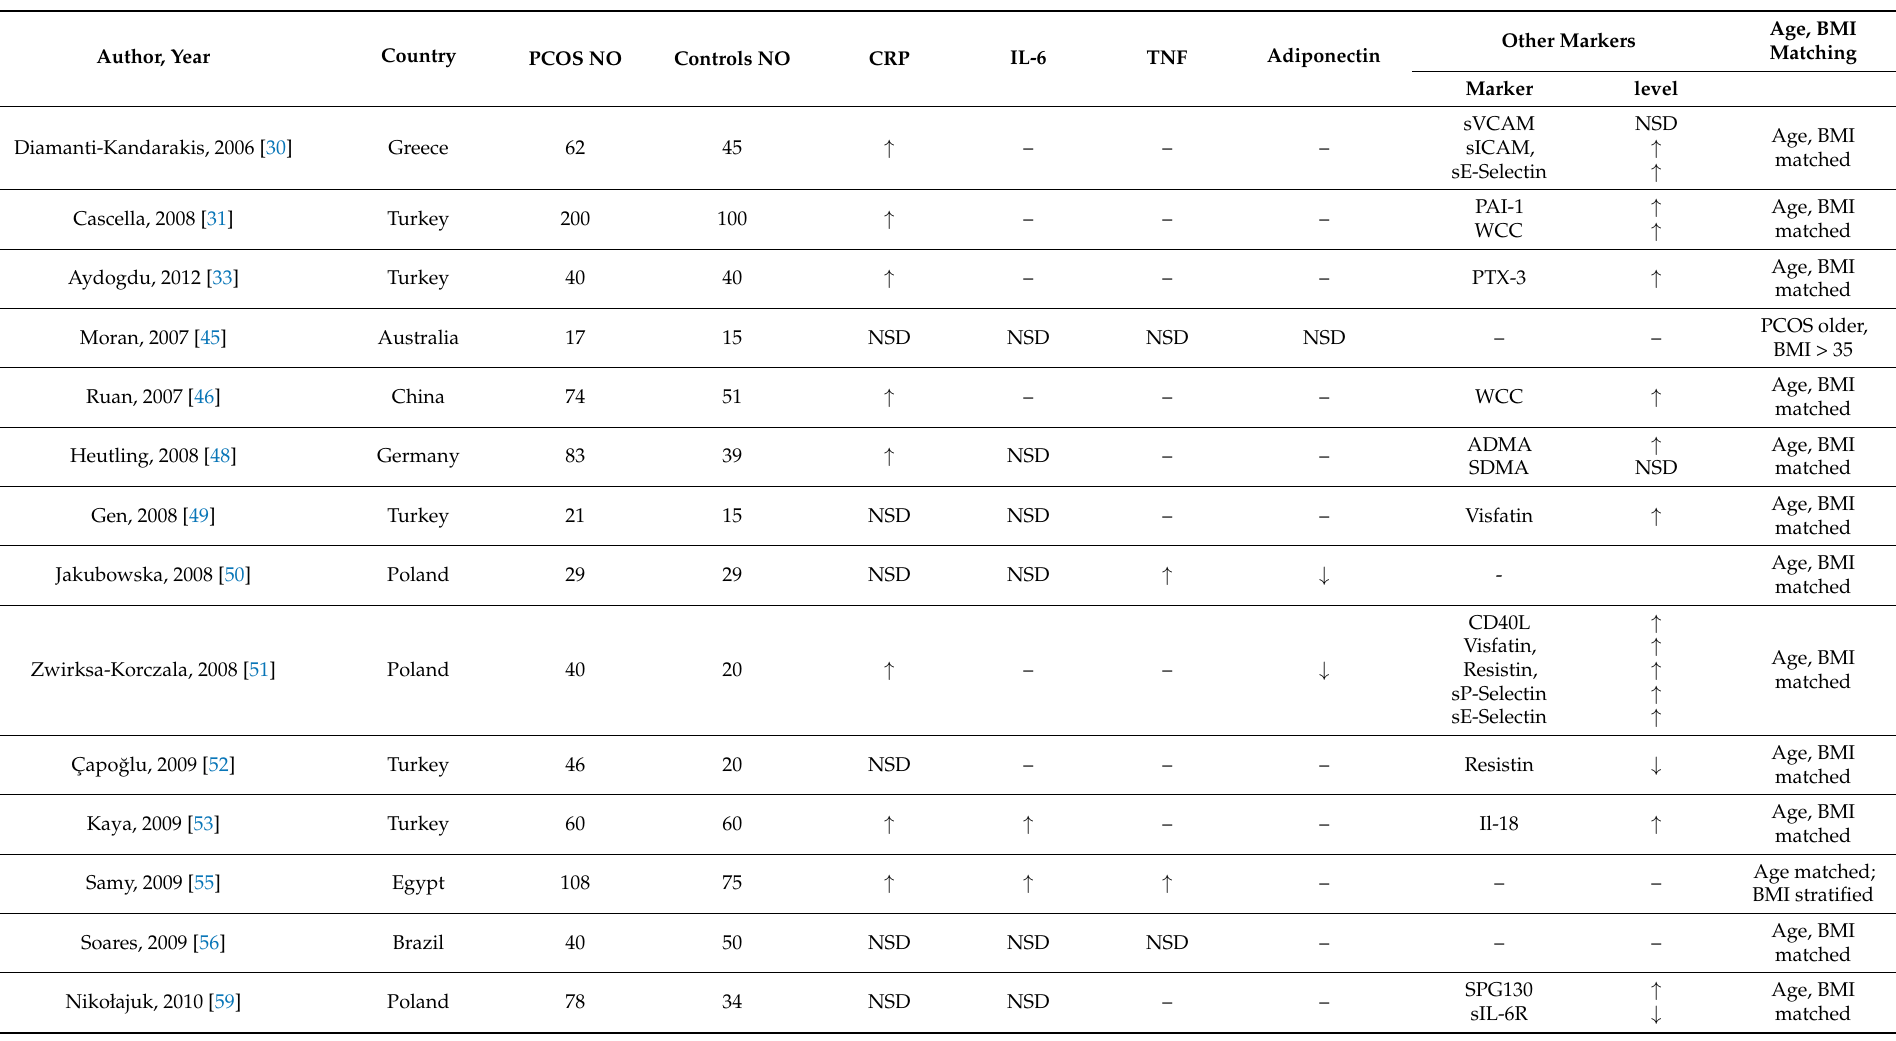
Table 3. Characteristics of 45 studies with other inflammatory